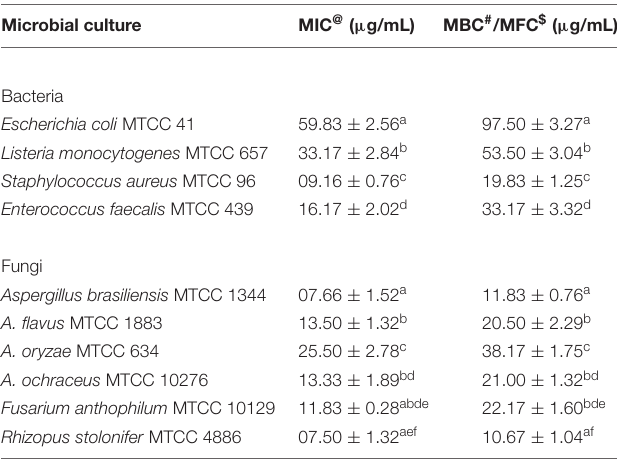
TABLE 1 | Antimicrobial effect of phytofabricated selenium nanoparticles (PF-SeNPs) from E. officinalis fruit extract on various foodborne pathogens determined by micro-well dilution